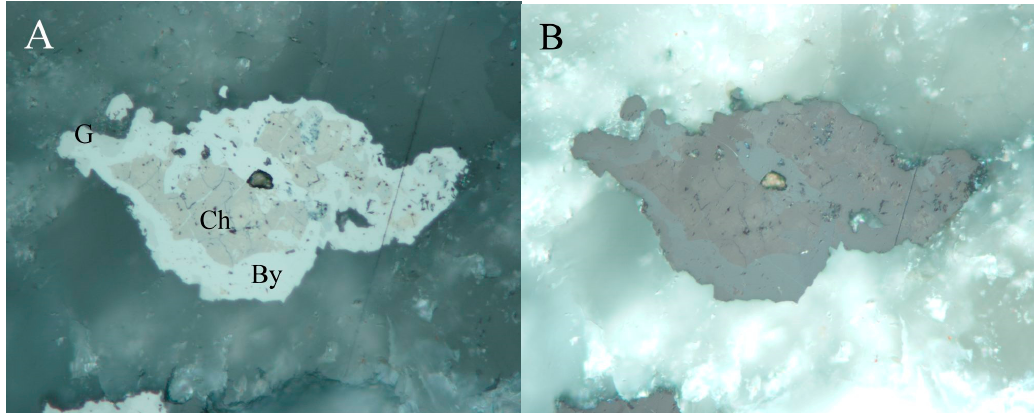
Figure 19. Light grey bytízite (By) forms a rim around brown chaméanite (Ch) with tiny light brown eskebornite inclusions. Dark grey giraudite (G) is in the association. Reflected light, ( A ) one polarizer, and ( B ) partly-crossed polarizers. FOV 210 μ m. P ř íbram, a dump of shaft 16. Photo by P.